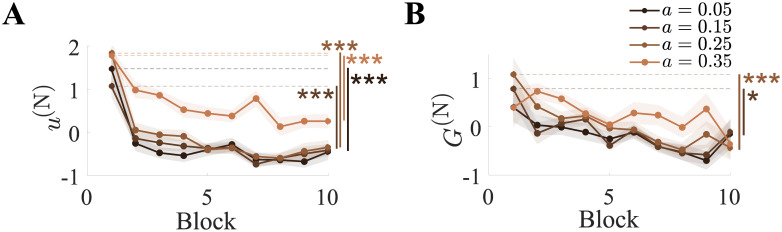
Co-contraction and the grasp force decreased with the block number.(A) Normalized muscle co-contraction u(N) and (B) grasp force G(N) as a function of the block number for each control parameter setting a. Both u(N) and G(N) decreased over time. * represents p < 0.05 and *** represents p < 0.001.